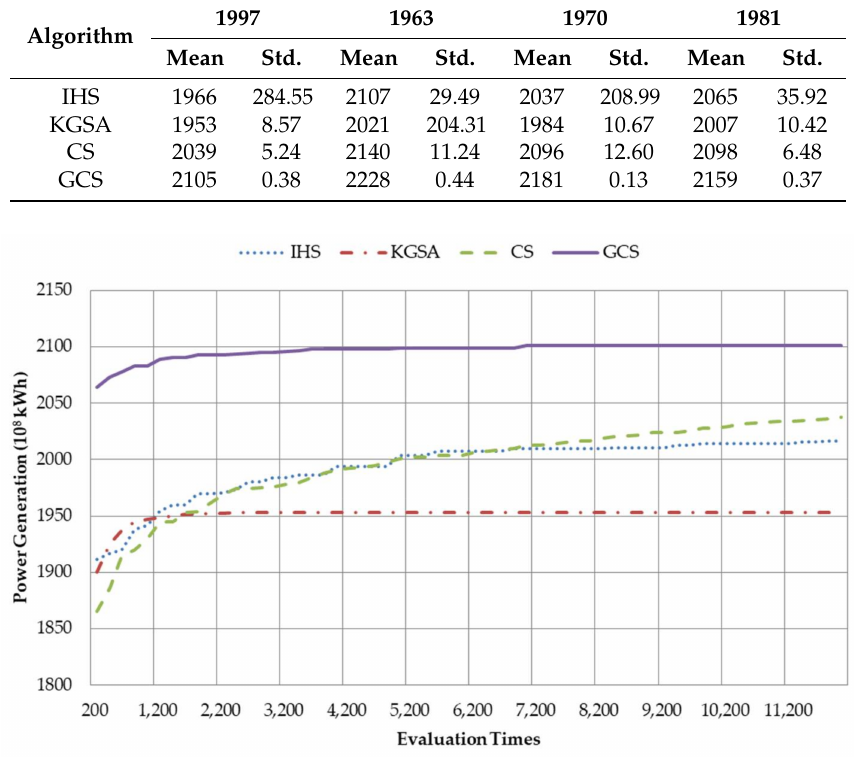
Figure 10. Convergence process of the algorithms in the year